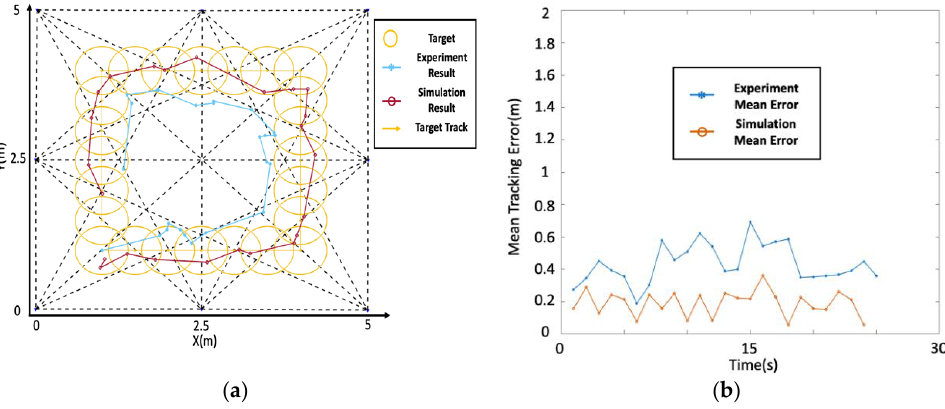
Figure 7. ( a ) Visualized tracking performance of the proposed GM algorithm. ( b ) Mean tracking errors between the predefined path and the estimated paths.